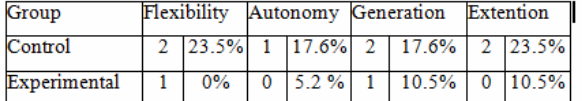
Table # 5: Results of assessments applied to students